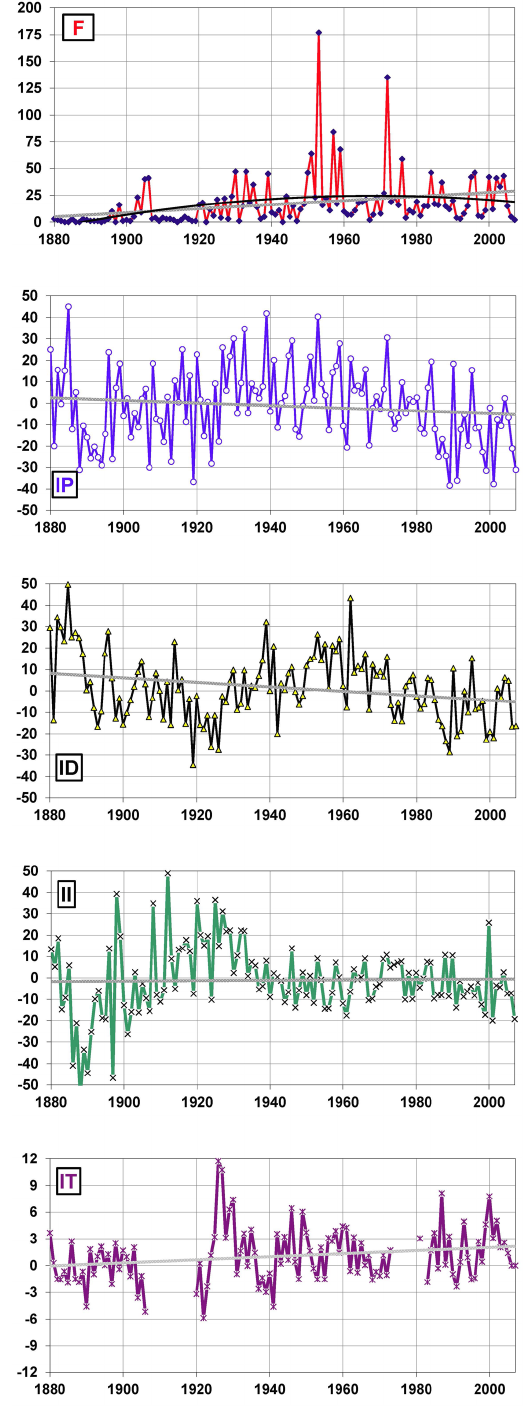
Fig. 6. Linear trend and time series of floods ( F ) and yearly indexes of precipitation (IP), wet days (ID), precipitation intensity (II), and temperature (IT). The linear trend is the grey line in each diagram; a polynomial trend line, shown in black, is added for F